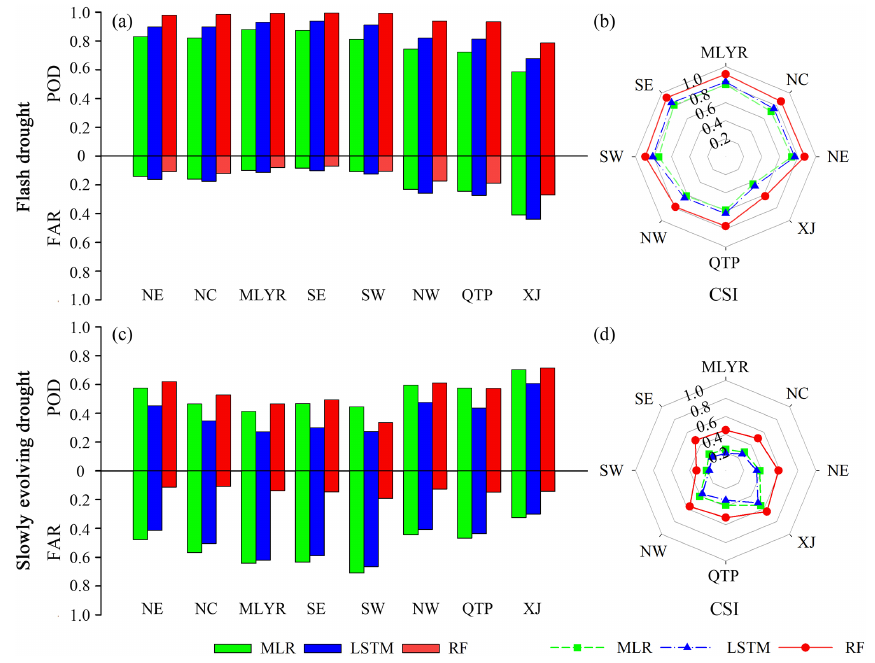
Figure 8. Skill scores of POD, FAR, and CSI for flash droughts and slowly evolving droughts based on the MLR, LSTM, and RF models in eight sub-regions.